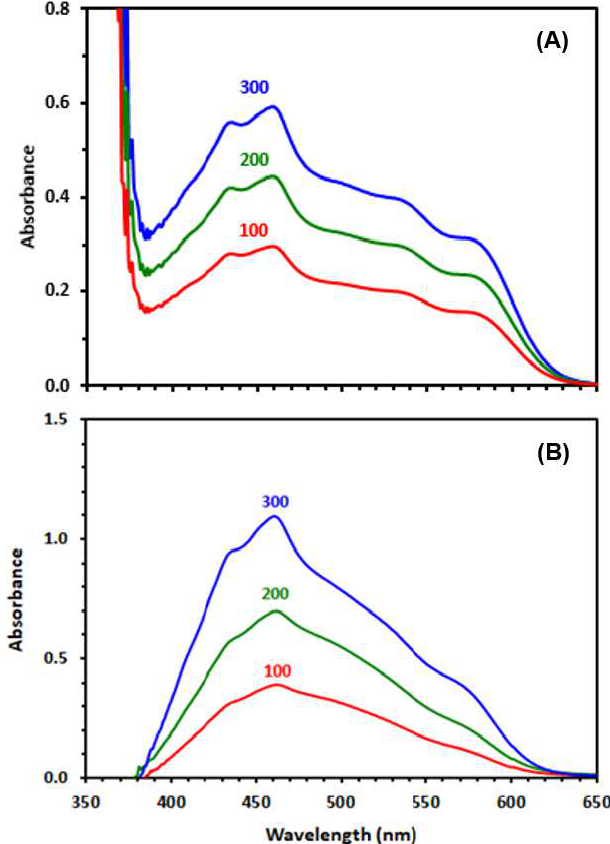
Figure 3. Absorption spectra of reaction mixtures of varying concentrations of DUV ( A ) and SEL ( B ) and with a fixed concentration of DDQ (0.1%, w / v ). The values given on the spectra are the concentrations of DUV and SEL in their reaction mixtures; concentrations were in μg/mL). All solutions were in methanol. In the additional confirmation for the CT property of the reaction, the red color of the reaction mixture disappeared upon its acidification with mineral acids. These results were approval of the formation of the CT complexes upon reactions of DUV and SEL with DDQ. Calculations were carried out to ascertain the band gap energy (Eg), which is the lowest amount of energy required to cause an excitation of an electron from its lower-energy valence band into its higher energy in order to participate in a conduction band formation [45]. Tauc plots (Figure 4) were generated for the Eg calculation by graphing energy values (hυ, in eV) against (αhυ) 2 . By projecting the linear portions of the graphs to (αhν) 2 = 0, the values of Eg were calculated [46]. For both DUV and SEL, the Eg was found to be 2.1 eV. This small value is indicative of the easiness of electron transfer from both DUV and SEL to DDQ and giving of the CTC absorption bands.